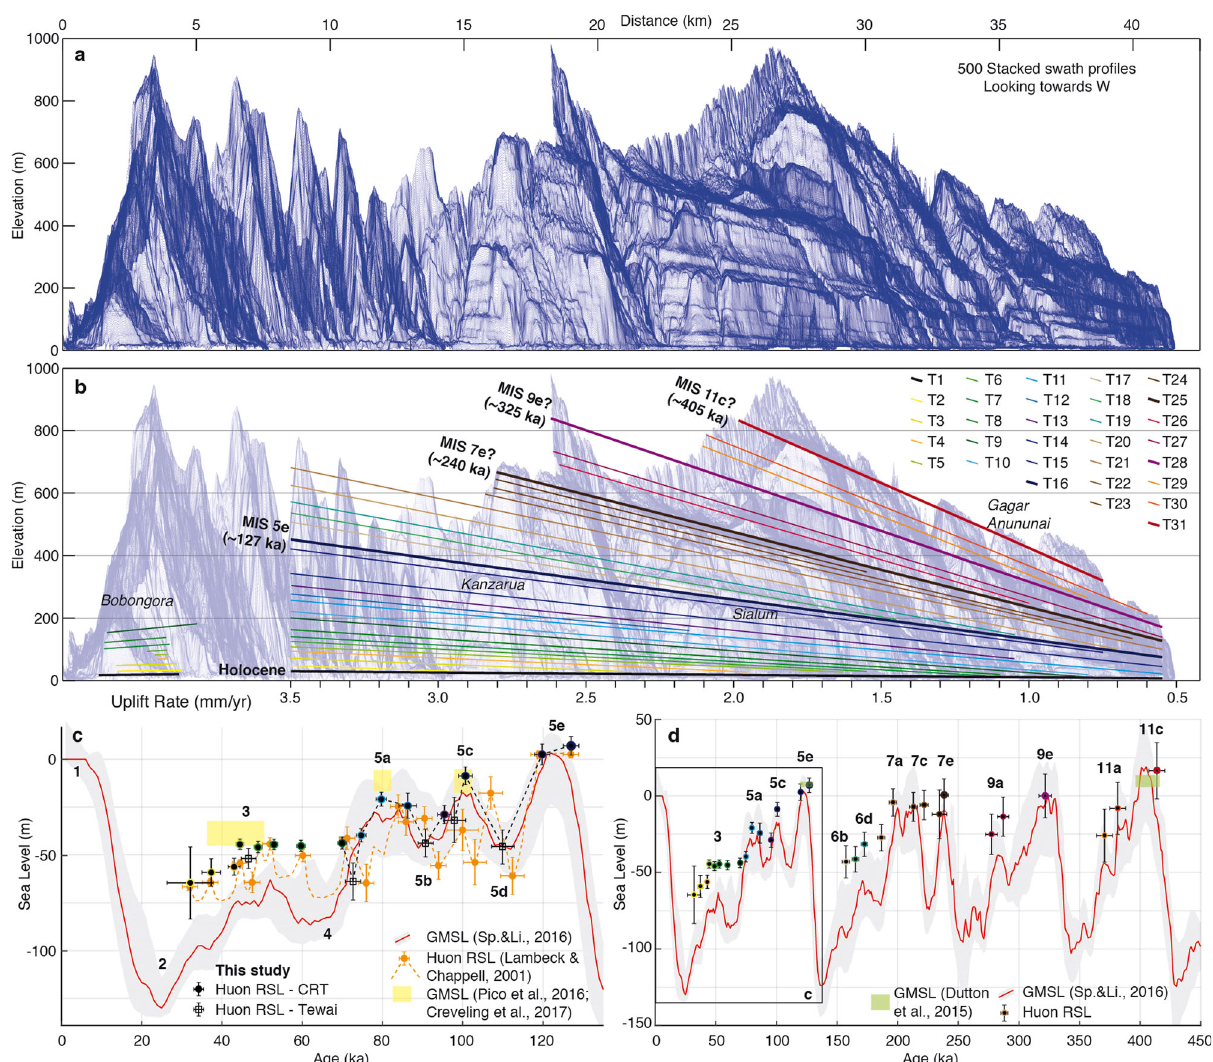
Fig. 3 Huon relative sea-level estimates. a 500 Stacked swath pro fi les of TanDEM-X Digital Surface Model looking towards the W with b interpretation of coral reef terrace levels. c Zoom-in to last glacial-interglacial cycle, with Huon relative sea-level estimates of this study obtained from coral reef terrace geometry in b (Huon RSL - CRT; halo colors as in b and perpendicular stacked swath pro fi les (Supplementary Data 3 and 4; see Methods). We compare these to previous Huon RSL estimates 11 , global mean sea-level estimates of MIS 3 35 , MIS 5a 36 , and MIS 5c 36 , and a global mean sea-level curve obtained with a Principal Component Analysis 4 with 97.5% con fi dence interval (grey band). Lowstand estimates (Huon RSL - Tewai) were re-calculated from other studies 11,33 (see Methods and Supplementary Table 3). Error bars for data points indicate Standard Errors (see Methods). d Same as c but for ~425 ka (halo colors as in b , and compared to independently constrained global mean sea-level estimates 32 (MIS 5e, 11c). Marine Isotope Stages (MIS; bold) follow a standardized de fi nition 88